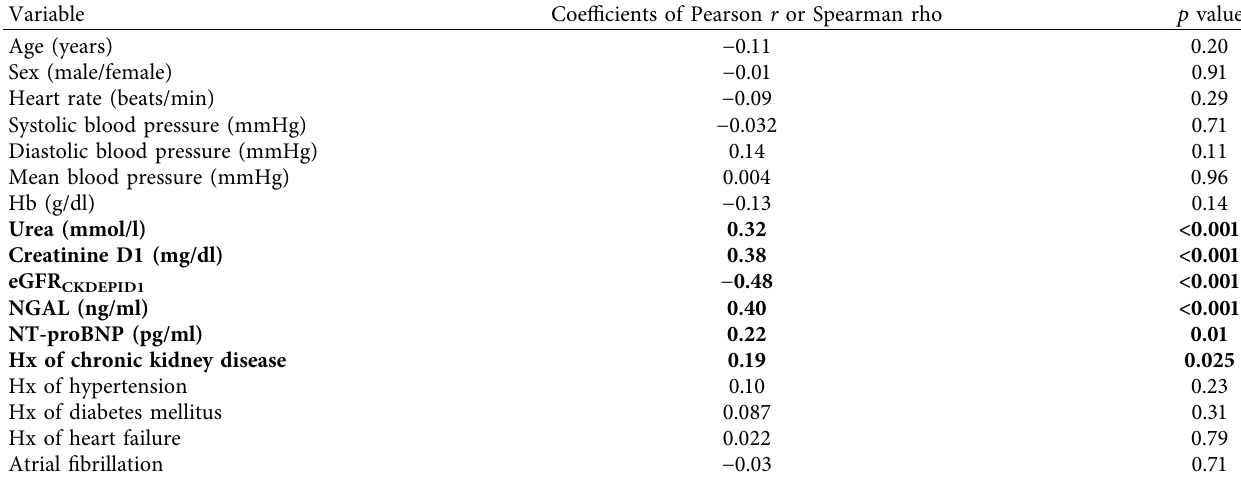
Table 3: The correlation between CRS1 and some variables.